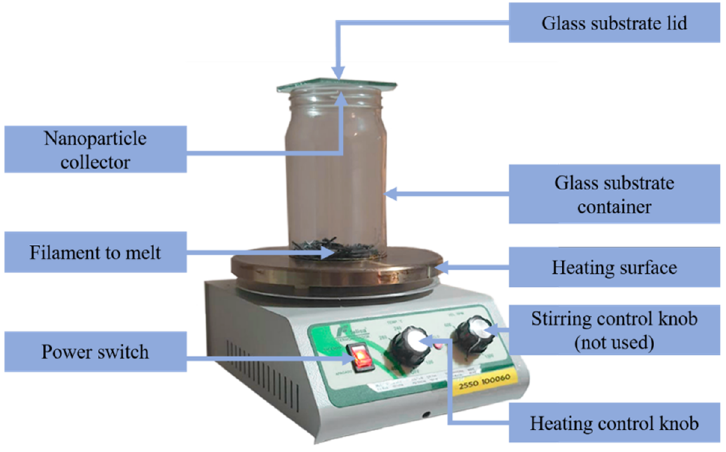
Figure 2. Nanoparticles collecting